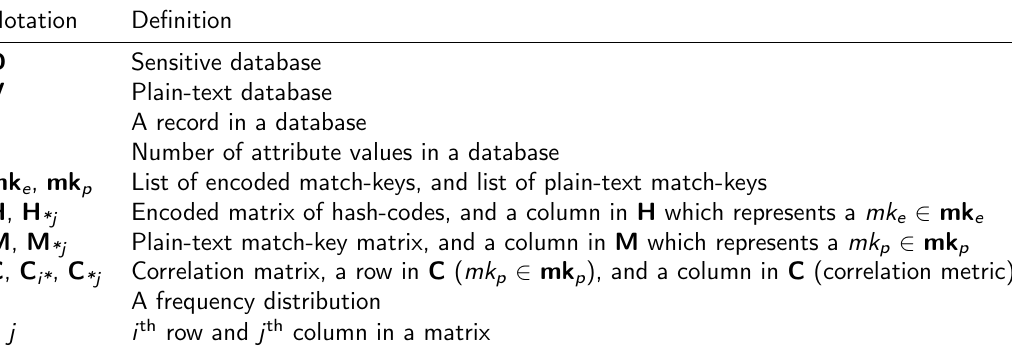
Table 1: Common notation used throughout the paper.